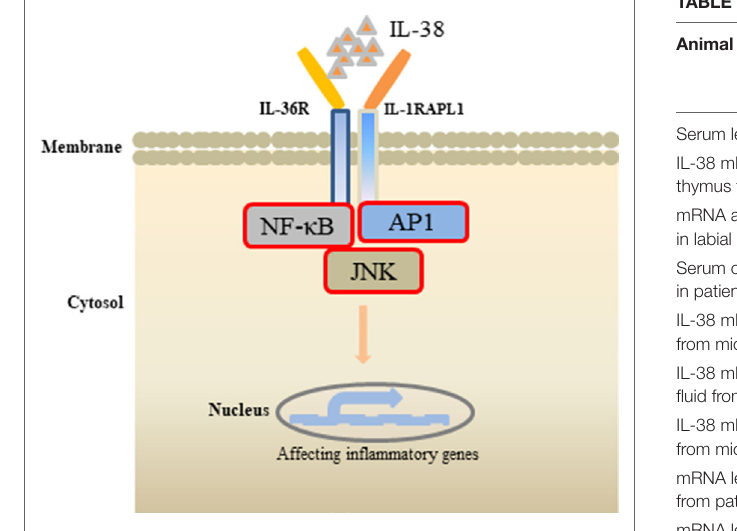
FigURe 2 | Effects of interleukin (IL)-38 binding. IL-38 binds to the receptors IL-1RAPL1 or IL-36R, exerts anti-inflammatory properties by inhibiting the downstream signaling pathways, such as NF- κ B, AP1, JNK, and, therefore, regulates the secretin of inflammatory